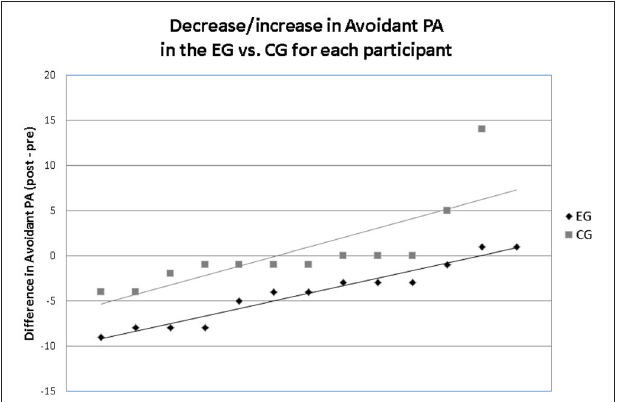
FIGURE 1 | Changes from pre- to post-test of each